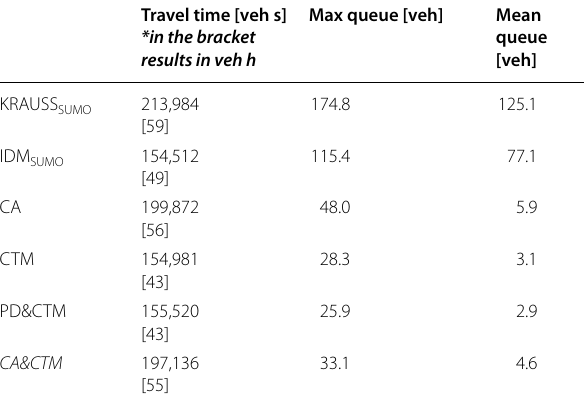
Table 5 Numerical results of the nine-node application Travel time [veh s] *in the